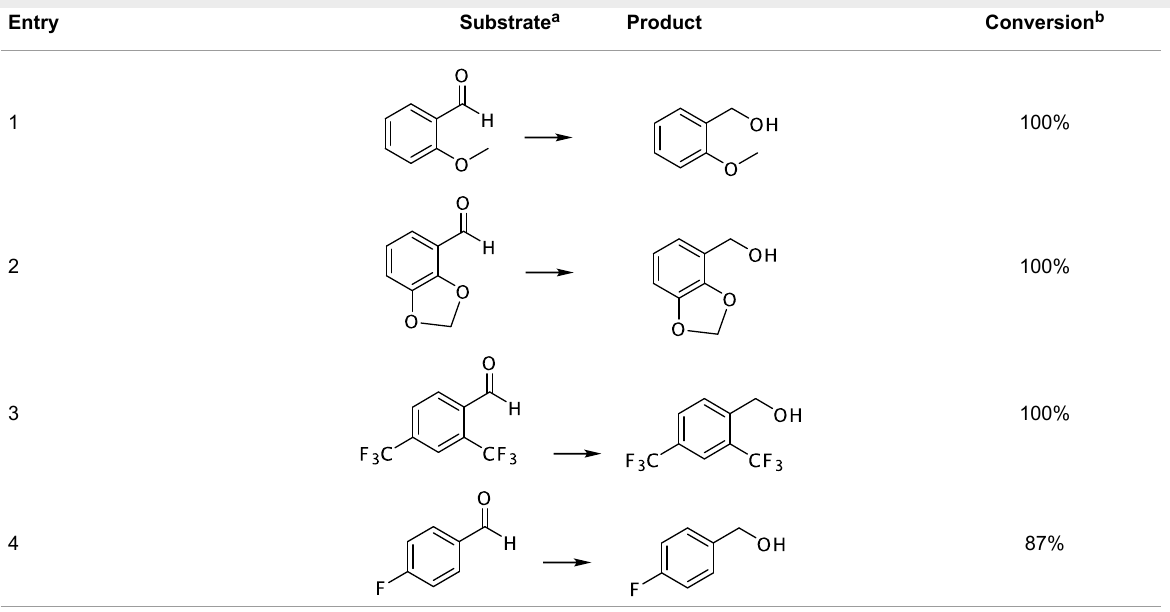
Table 2: Pd(0)EnCat™30NP-catalyzed hydrogenation of aryl ketones and aldehydes. Entry